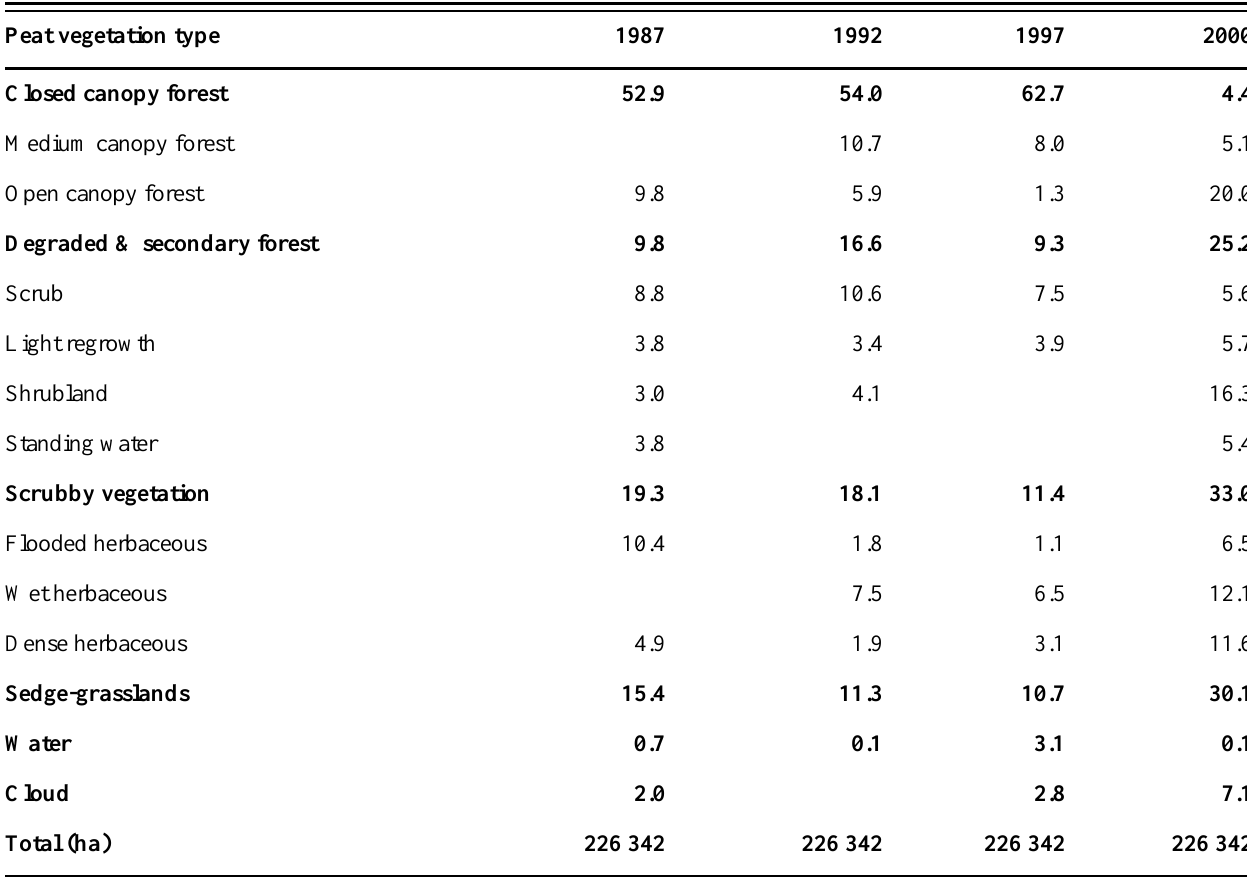
Table 2. Percent cover of different vegetation types on the Middle Mahakam Peatlands from 1987 to 2000 Peat vegetation type 1987 1992 Closed canopy forest Medium canopy